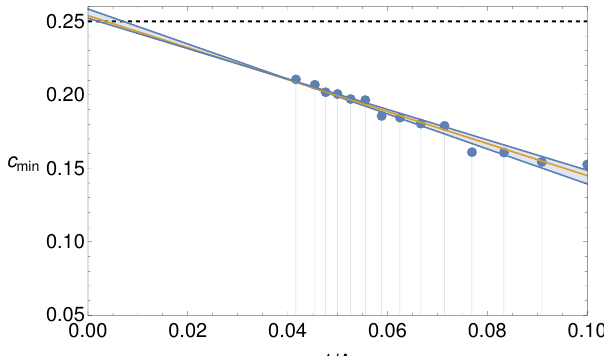
Figure 1 . Numerically minimum allowed central charge for the ^ B as a function of the inverse of the number of derivatives (cid:3). The dashed horizontal line marks the central charge of the U(1) N = 4 SYM theory. The middle orange line shows a linear (cid:12)t to all the data points, while the top and bottom blue lines show (cid:12)ts to di(cid:11)erent subsets of the